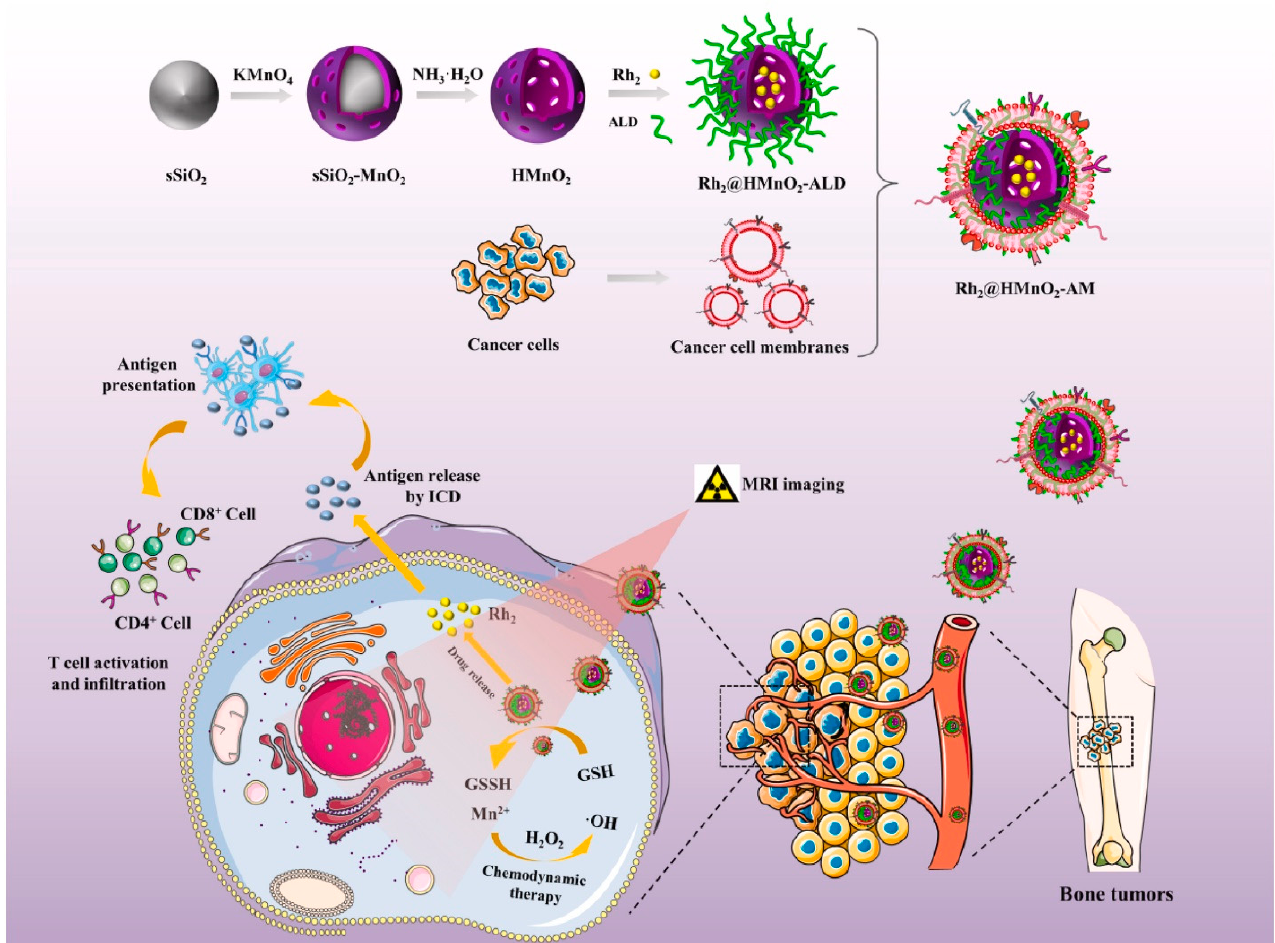
(Figure 14). The as-designed nanoplatforms are suitable for MRI-guided immuno- chemo- dynamic combination therapy against osteosarcoma.